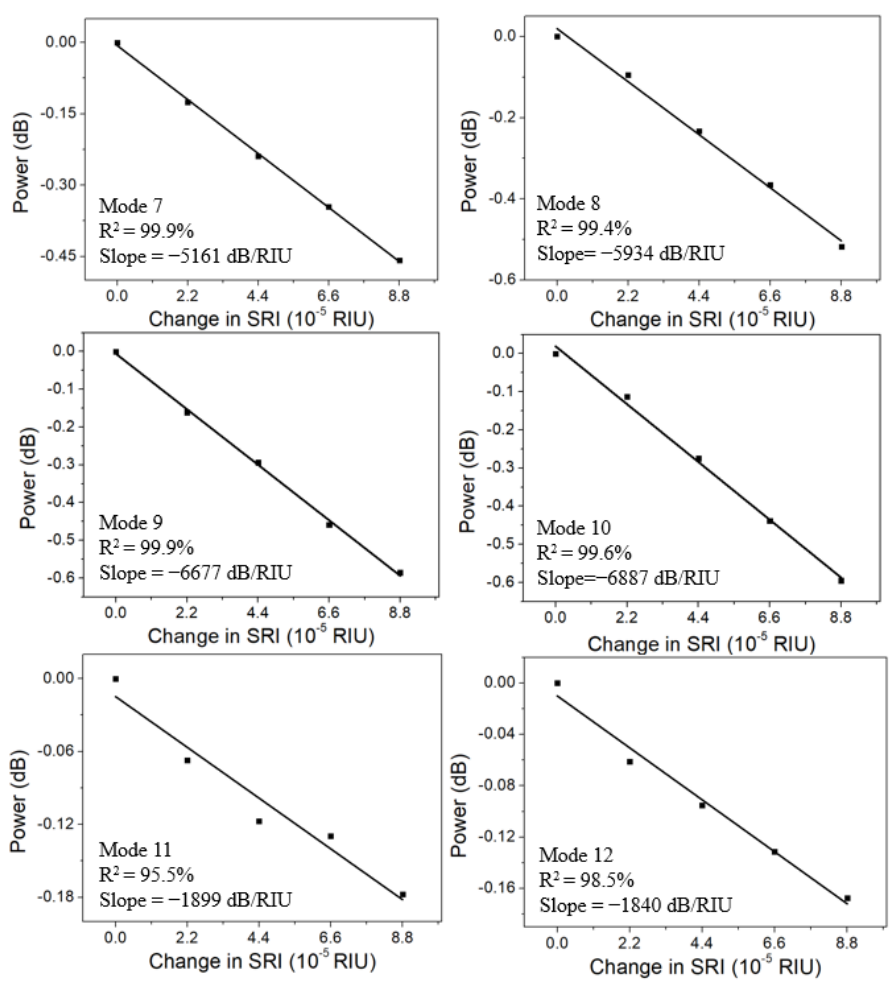
Figure 7. Linear regressions of the amplitudes of the cladding modes No. 7–No. 12 in different glucose aqueous solutions (refractive index ~1.3573) with a SRI change of 8.8 × 10 − 5 . To avoid the downside, only the linear regressions for the cladding modes (No. 7– No. 10) with 𝑅 (cid:2870) higher than 99% showing good linearity were considered. After compar- ison, the most sensitive cladding mode No. 10 with a sensitivity of − 6887 dB/RIU was obtained, whose spectral variation is presented in the inset of Figure 6. On the contrary, the linear regressions for cladding modes No. 11 and No. 12 with lower 𝑅 (cid:2870) , which are